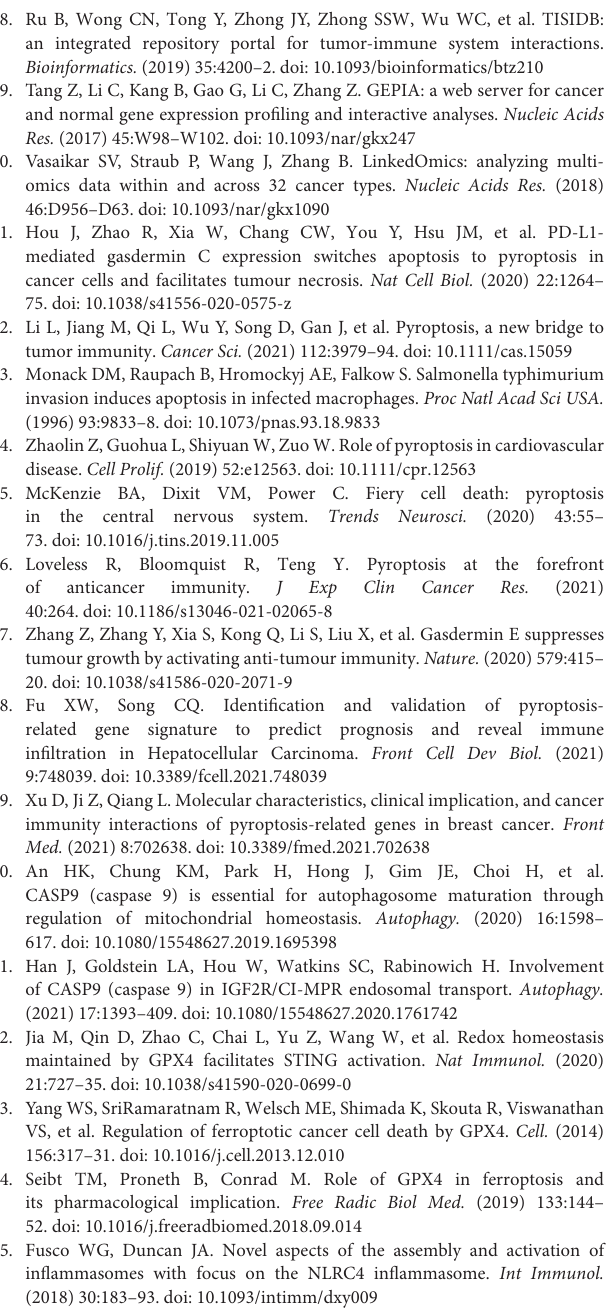
Supplementary Table 3 | Detailed information of pyroptosis-related seven-gene